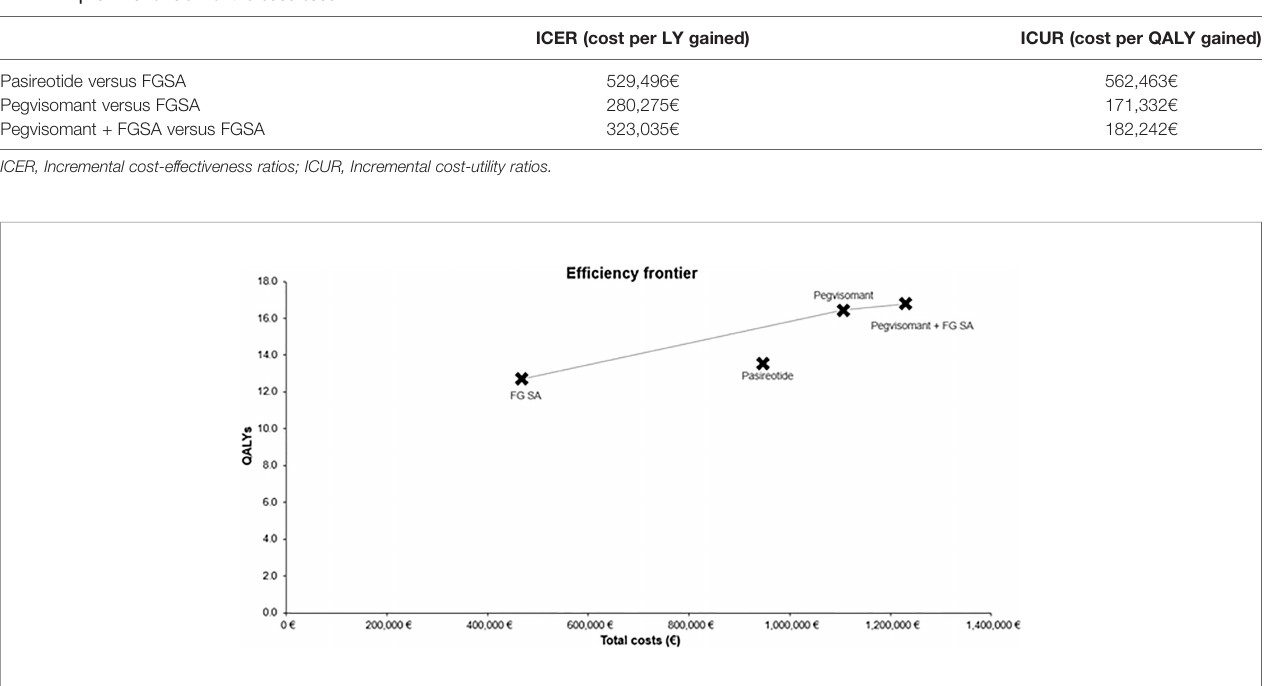
FIGURE 2 | Cost-utility frontier of the base case